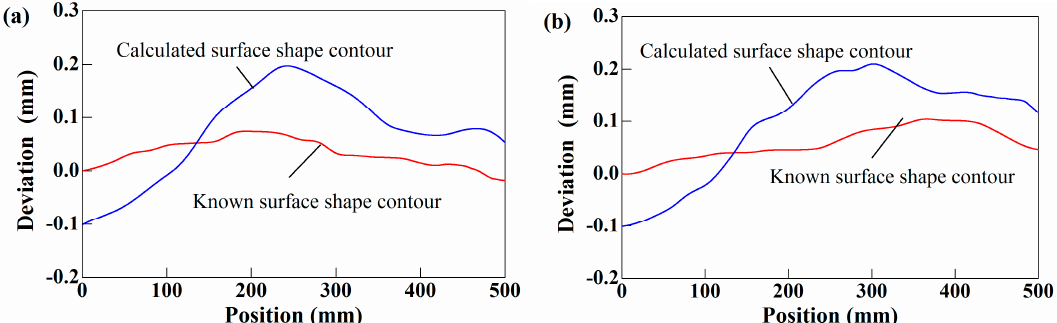
Figure 34. Comparison between calculated surface shape contour and known surface shape contour: ( a ) PD is the measured surface ( b ) PC is the measured surface.